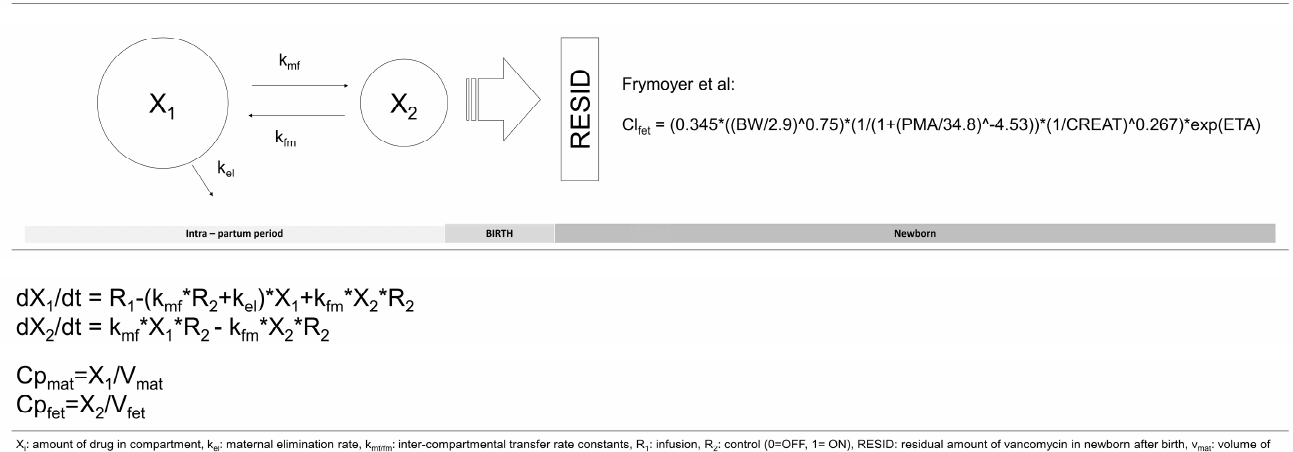
Figure 2. Intrapartum intravenous vancomycin model structure and equations.